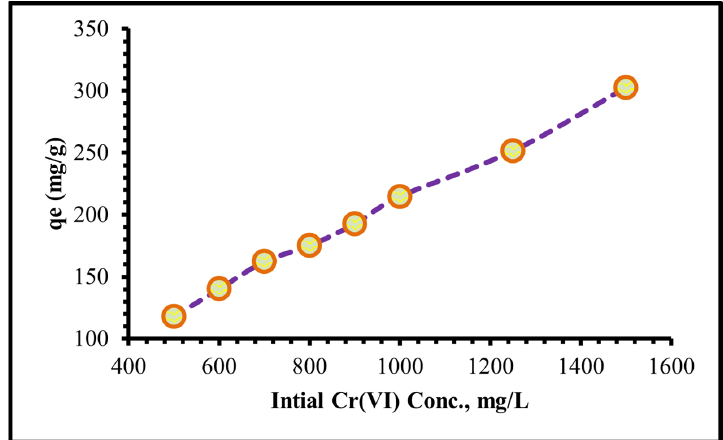
Figure 10. influence of initial Cr(VI) concentration upon TIHP uptake.